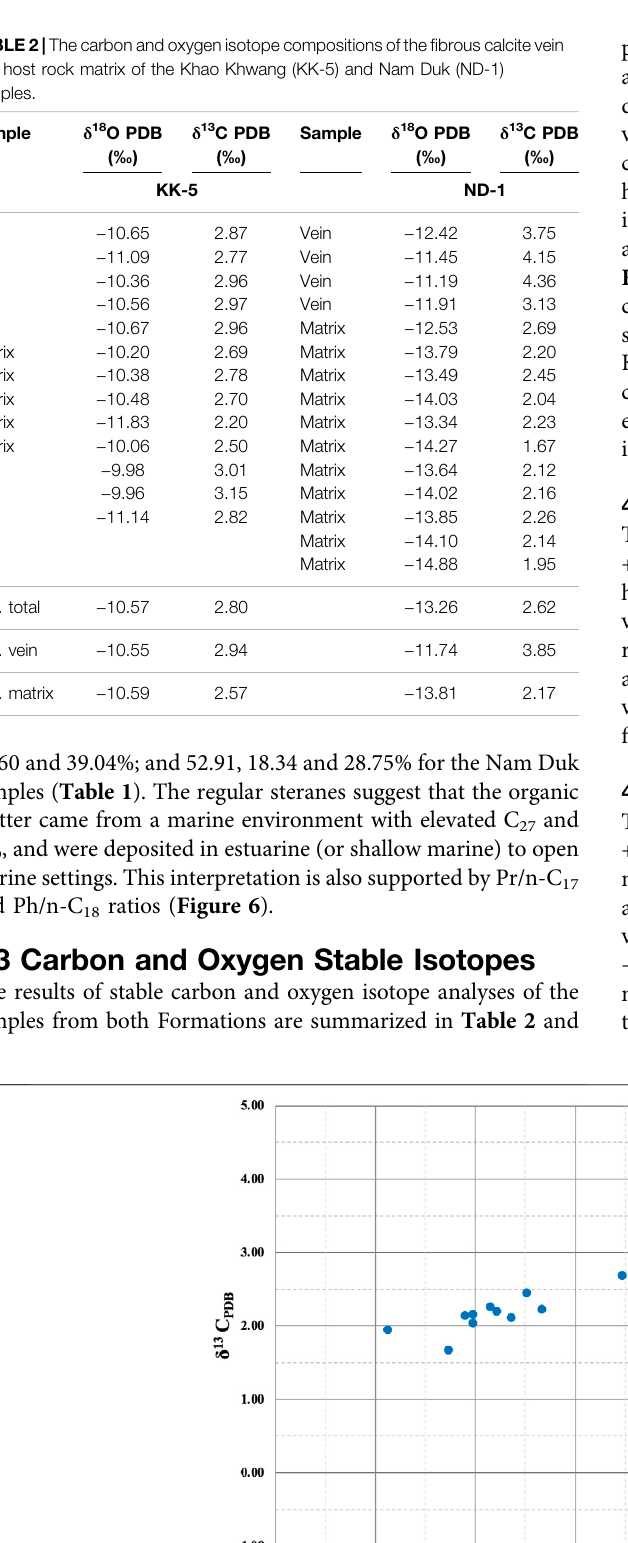
Frontiers in Earth Science |